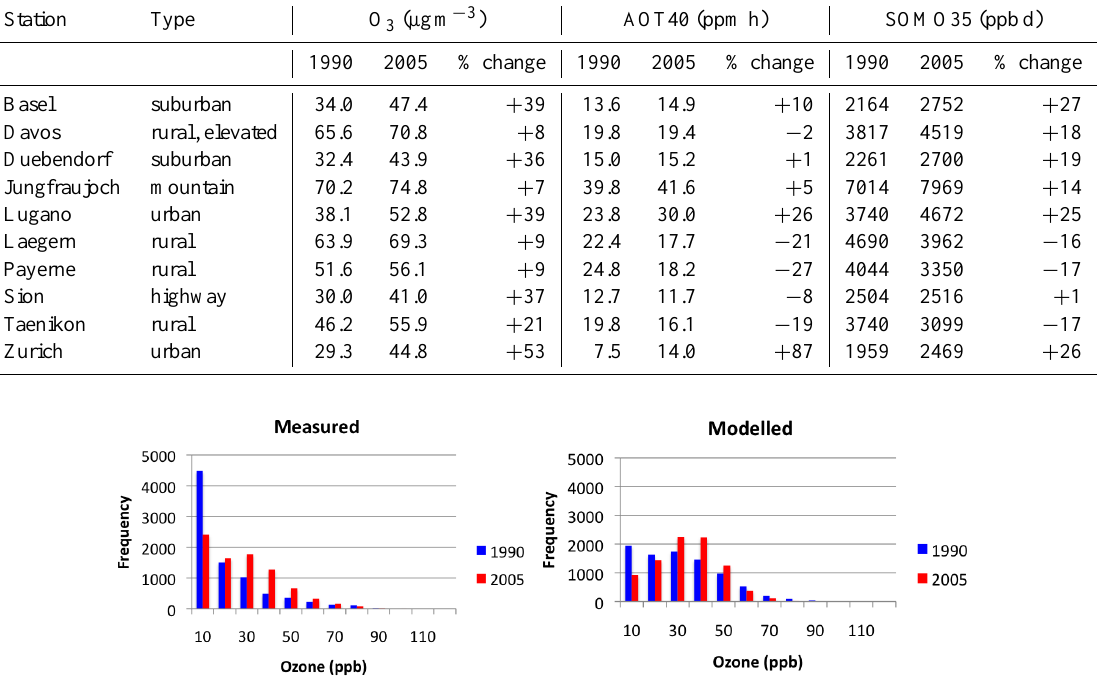
Table 3. Mean O 3 , AOT40 and SOMO35 from measurements at NABEL stations in Switzerland (FOEN). Station